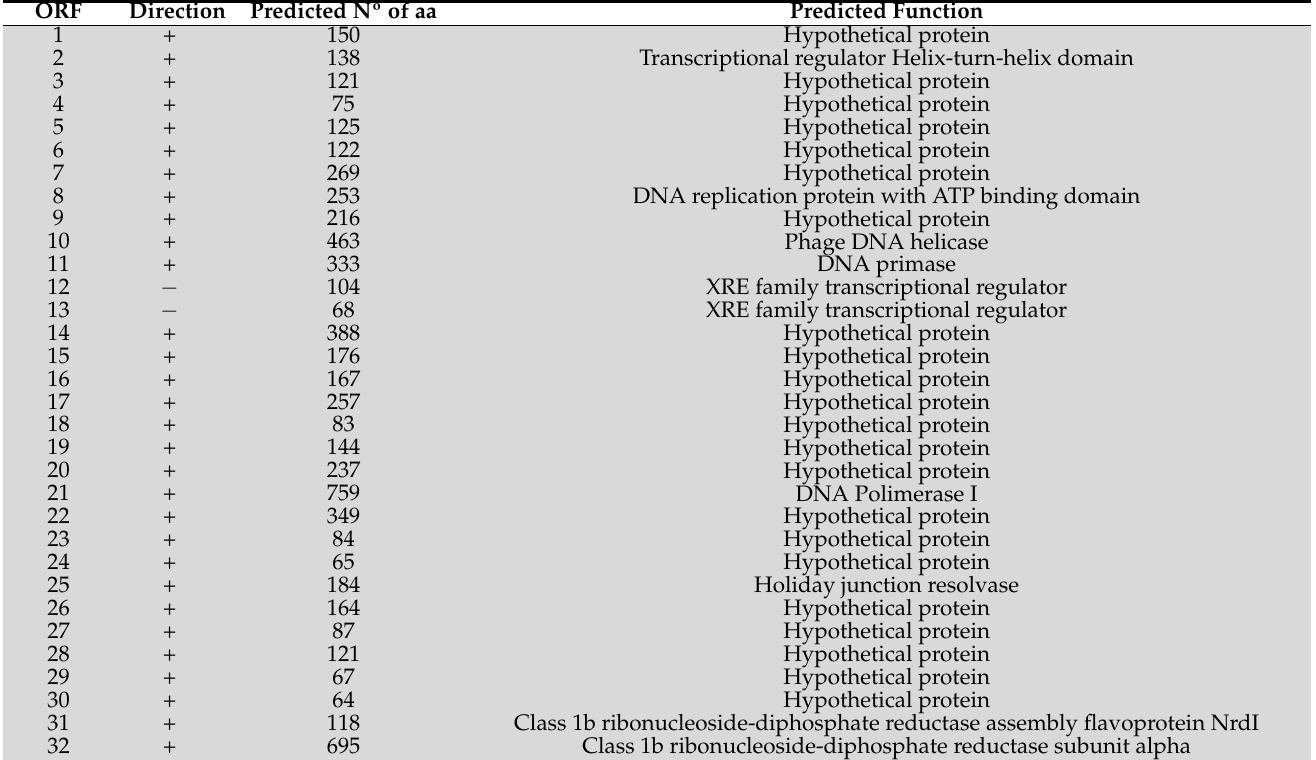
Table 3. Predicted ORFs in the 60.213 Kb region identified by